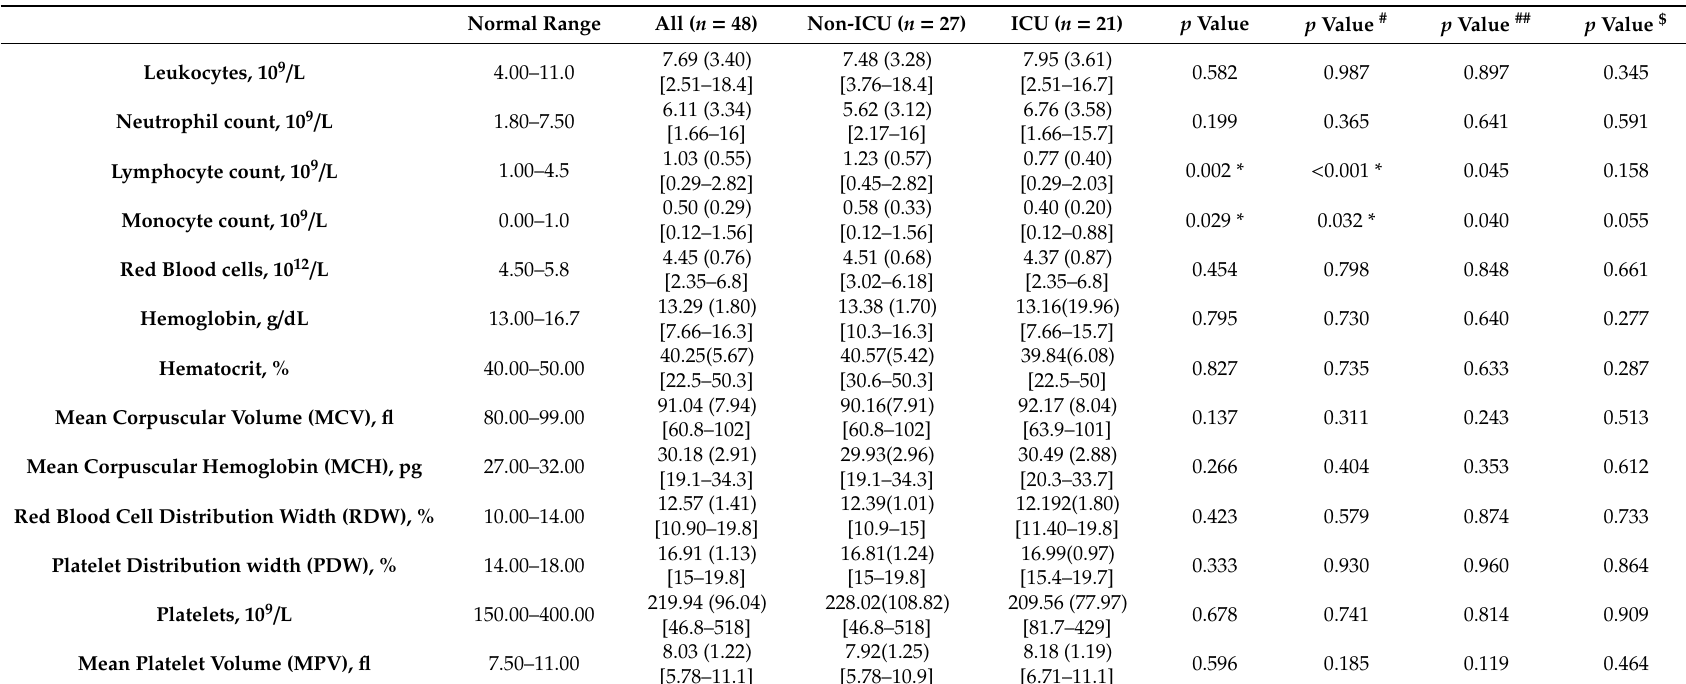
Table 2. Baseline laboratory measures of 48 Patients with COVID-19 at triage, prior to hospitalization.